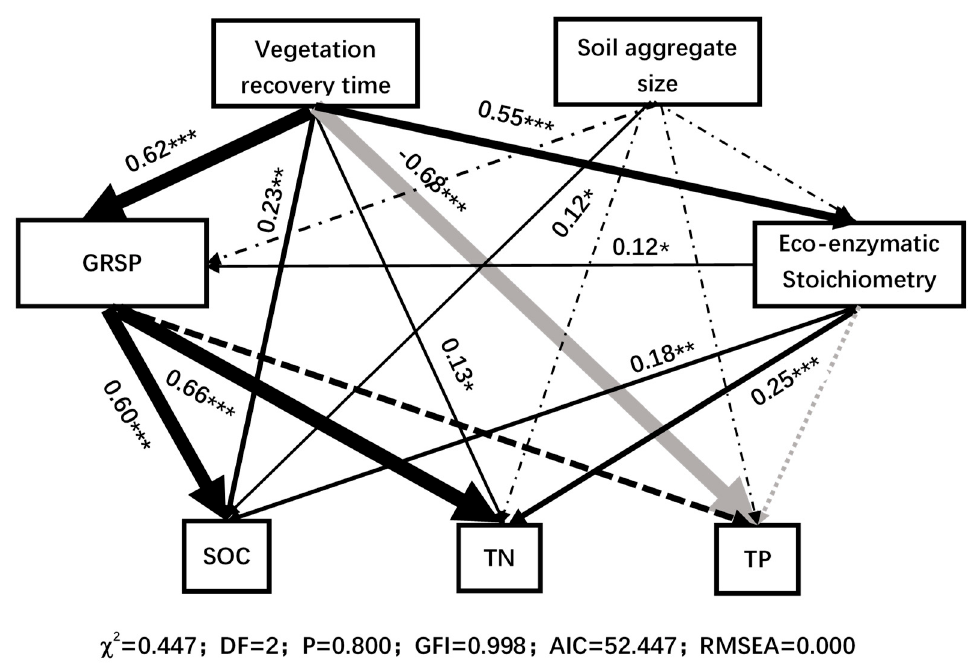
Figure 7. Structural equation model of the effects of vegetation restoration on soil aggregate nutrients, GRSP, and Eco-enzymatic Stoichiometry. Solid arrows indicate positive relationships, gray arrows indicate negative relationships and dashed arrows indicate no significant correlation. *, p < 0.05, **, p < 0.01, ***, p < 0.001.